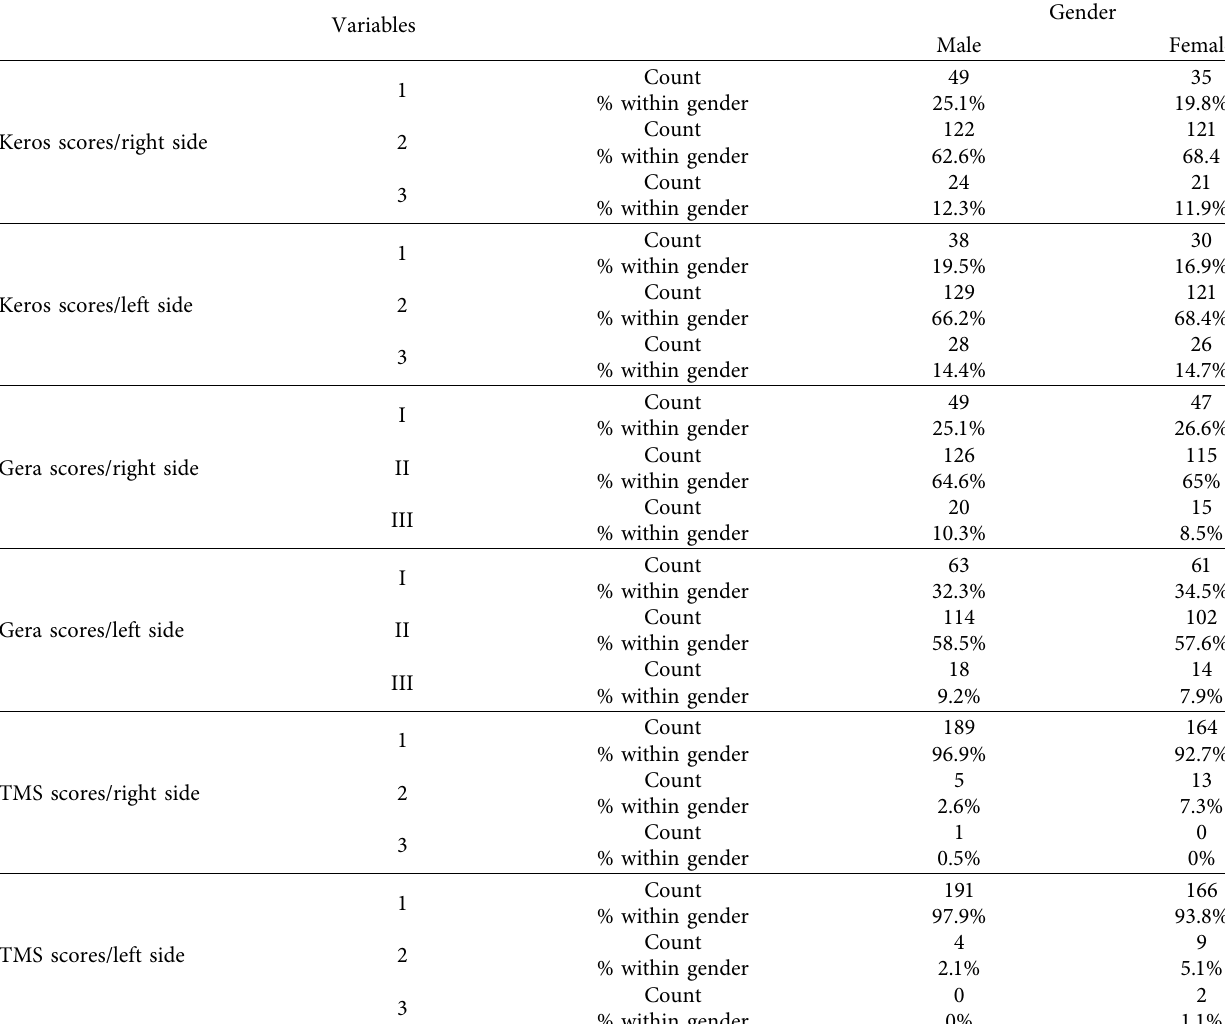
Table 1: The distribution of Keros, Gera, and TMS scores according to the sides and gender.